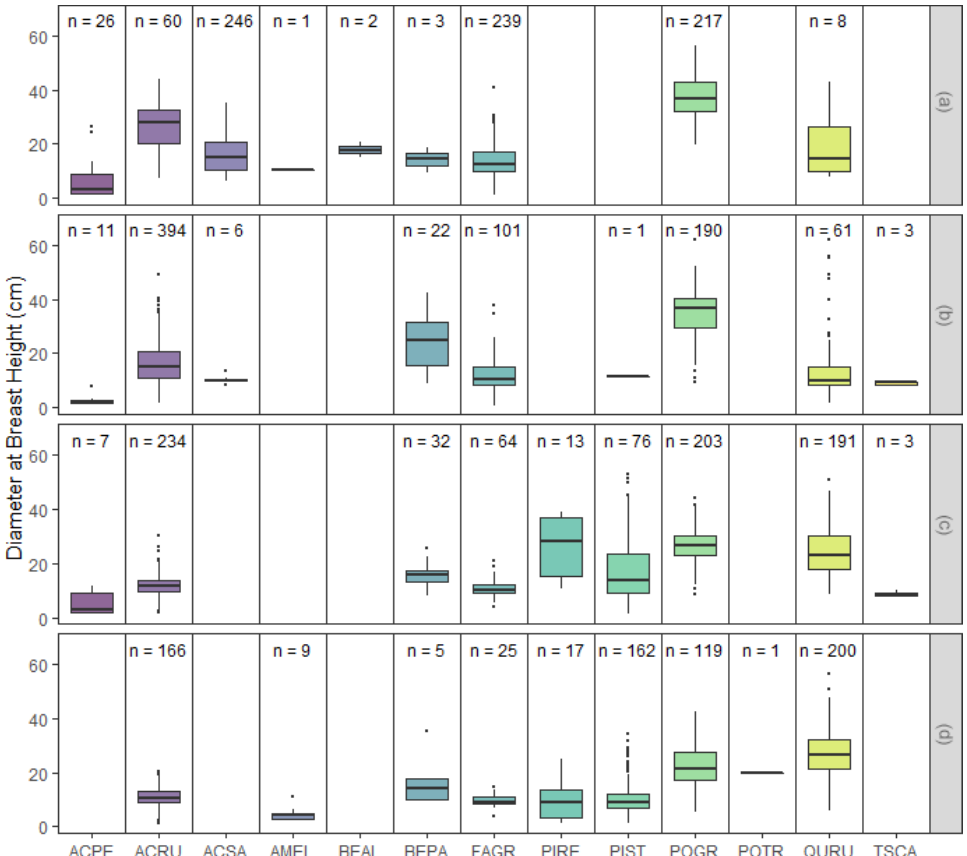
Figure 3. Diameter at breast height (DBH) distributions for each species, grouped by replicate. The bounds of each box in the box plot represent the 25th percentile at the lower bound and the 75th percentile at the upper bound, and the horizontal line is the median. Lines extending from the lower and upper bounds represent values that are 1.5 times the interquartile range for the minimum and maximum values, respectively, while black circles indicate outliers. Above each box plot, n is the number of